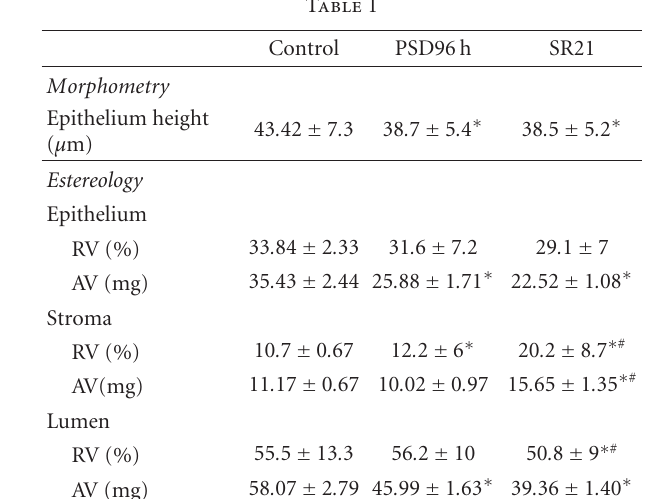
Values represent means ± SEMs of the data obtained for stereological and morphometrical analyses of three experimental groups: control, PSD96h and SR21. Statistical analyses based on ANOVA and Tukey tests. Significance P < 0 . 05. ∗ Di ff erent from control group and di ff erent from PSD96h. RV: relative volume. AV: absolute